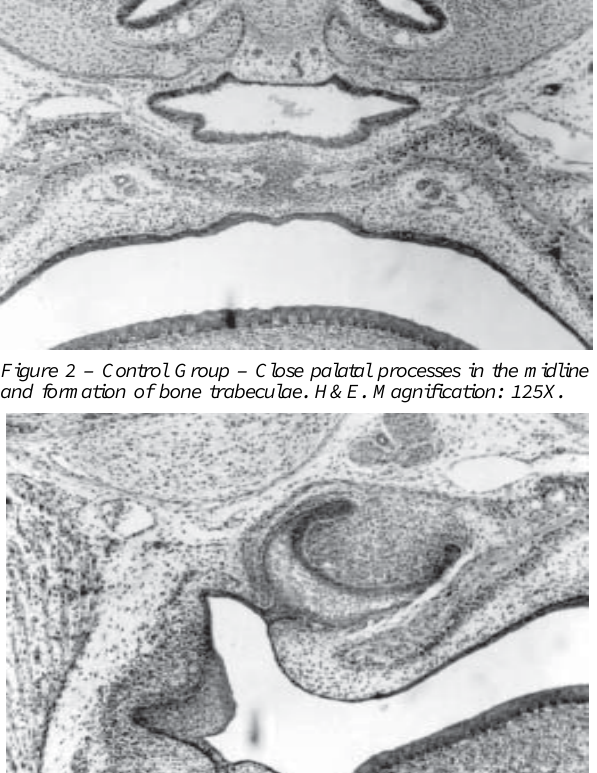
Figure 3 – Control Group – First maxillary molar germs. Cap Phase. H&E. Magnification: